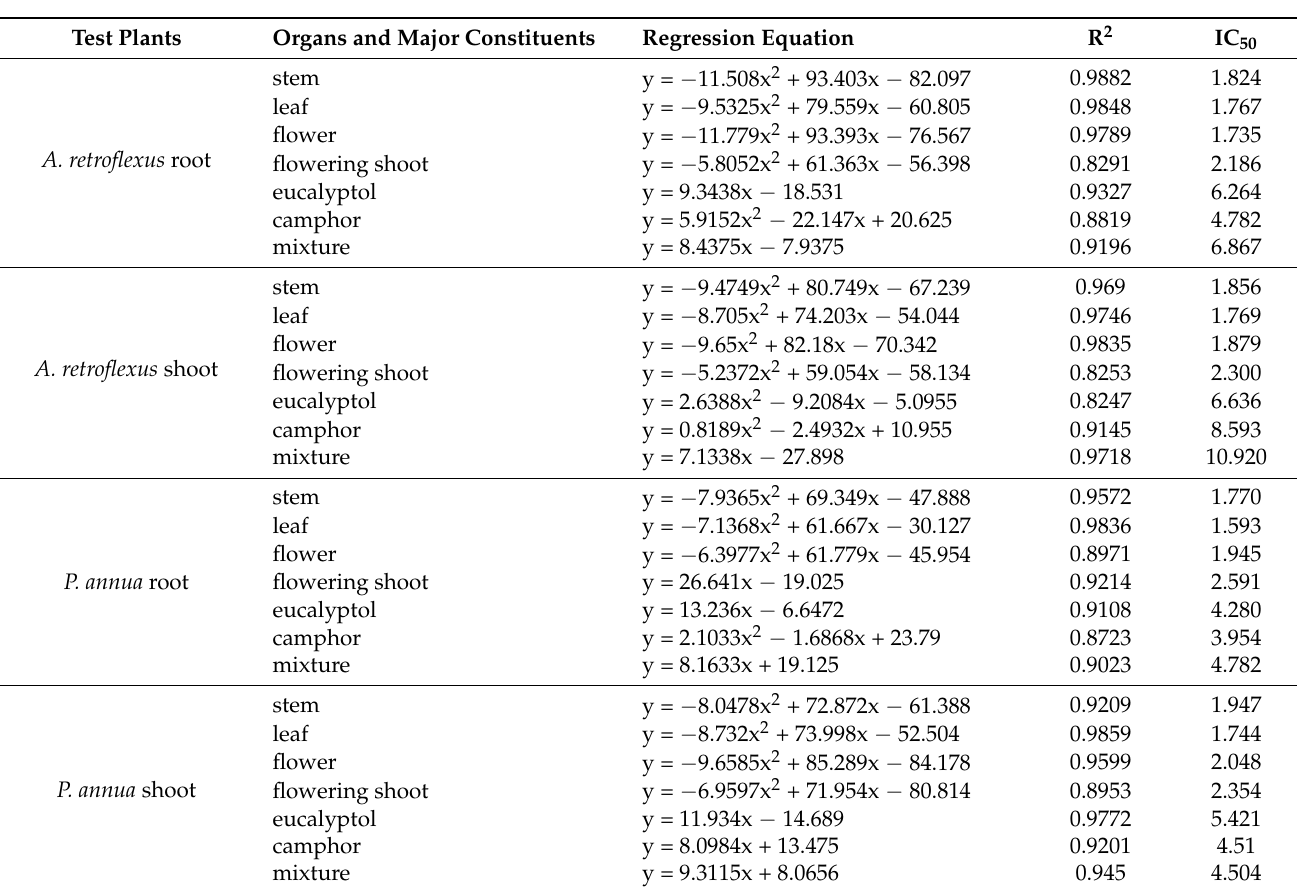
Table 2. IC 50 (mg/mL) values of S. kaschgaricum volatile oils and their major constituents on root and shoot length of A. retroflexus and P. annua